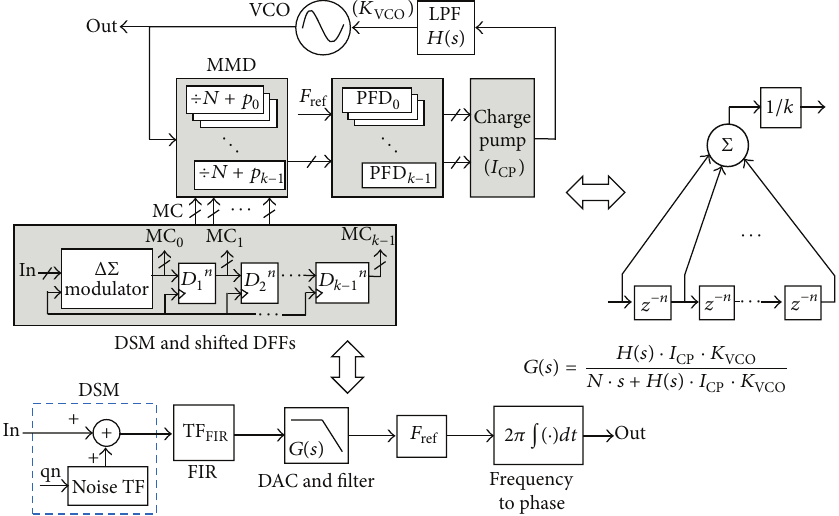
Figure 2: Conceptual diagram and signal model of FIR-embedded ΔΣ PLL with DSM noise